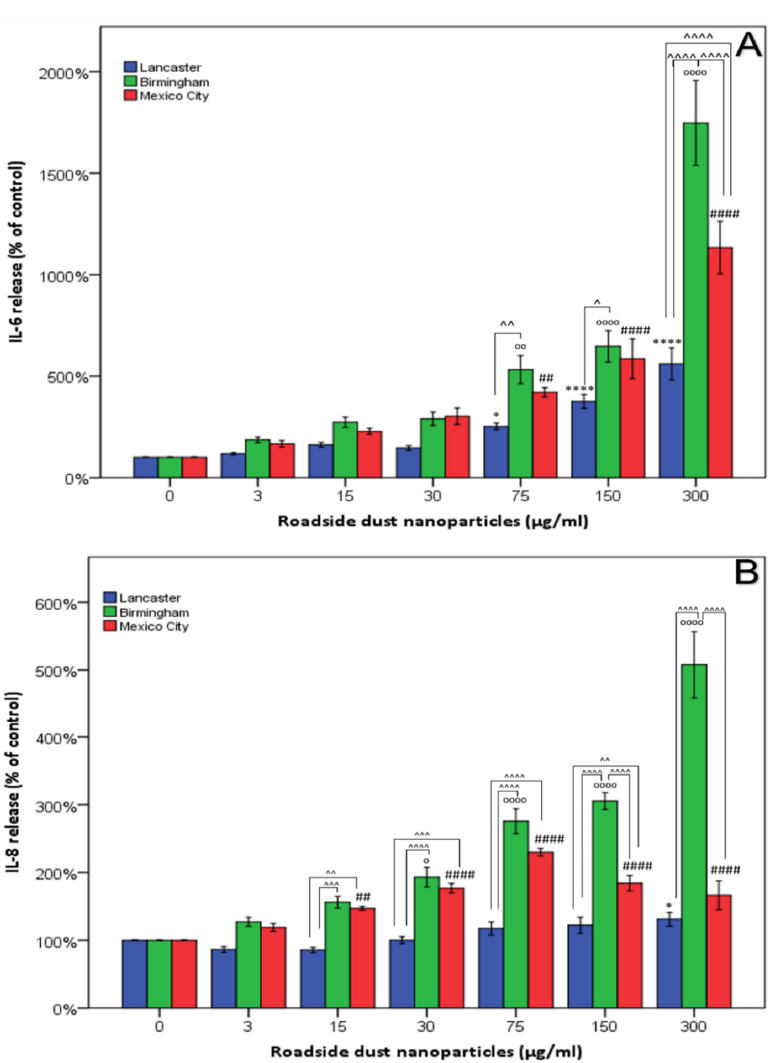
Figure 5. Release of pro-inflammatory cytokines in Calu-3 cells treated with <220 nm-sized road- deposited dust particles (UF-RDPs). Calu-3 cells were exposed (0–300 µg/mL) to UF-RDPs from Lancaster and Birmingham (UK) and Mexico City (Mexico) for 24 h. IL-6 ( A ) and IL-8 ( B ) concentra- tions in the media were quantified via ELISA. Data were adjusted using MTS (cell viability) data from Calu-3 cells treated in the same manner. A one-way ANOVA with Dunnett’s post hoc was conducted, comparing treated cells to the untreated control. (* Lancaster, 0 Birmingham, # Mexico City) and two-way ANOVA with Bonferroni correction to compare the impacts of the UF-RDPs from the three different locations (ˆ). Statistical significance levels used are: *, p ≤ 0.05; **, p ≤ 0.01; ***, p ≤ 0.001; ****, p ≤ 0.0001 where * may be substituted for ˆ, # or 0 depending on the city or comparison being